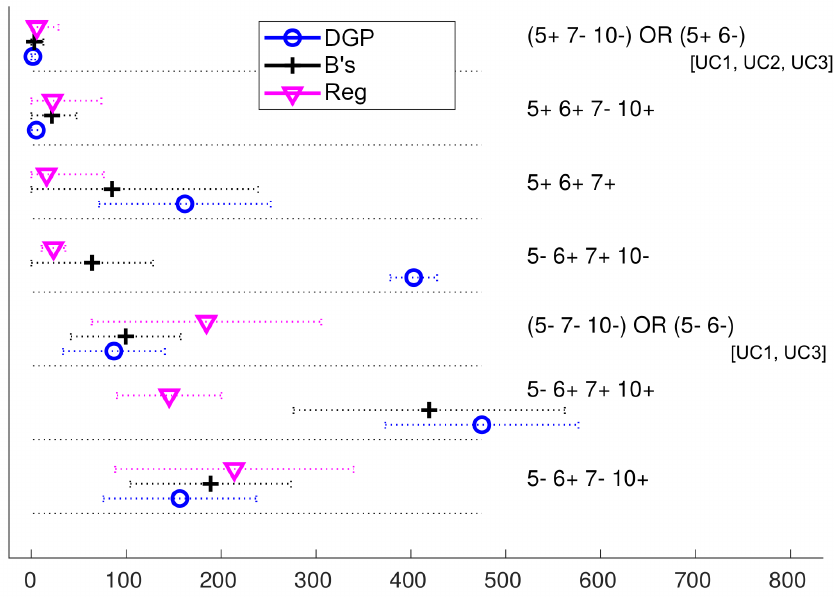
Figure A3. The seven distinctive behaviours found in the scenarios for M 2 ( β R − entry ) when α R (cid:54) = 1 (consequently, axes 3 and 4 must be at different extreme positions).